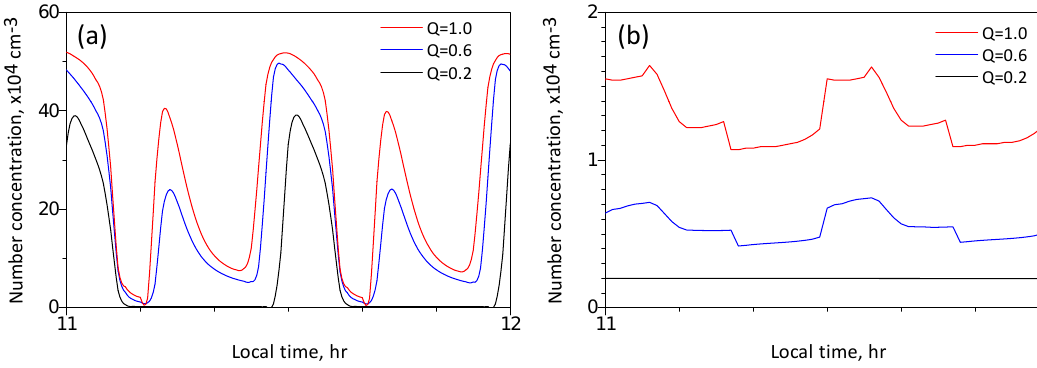
Fig. 9. Same as Fig. 7, but zoom up for the period between 11a.m. and noon.